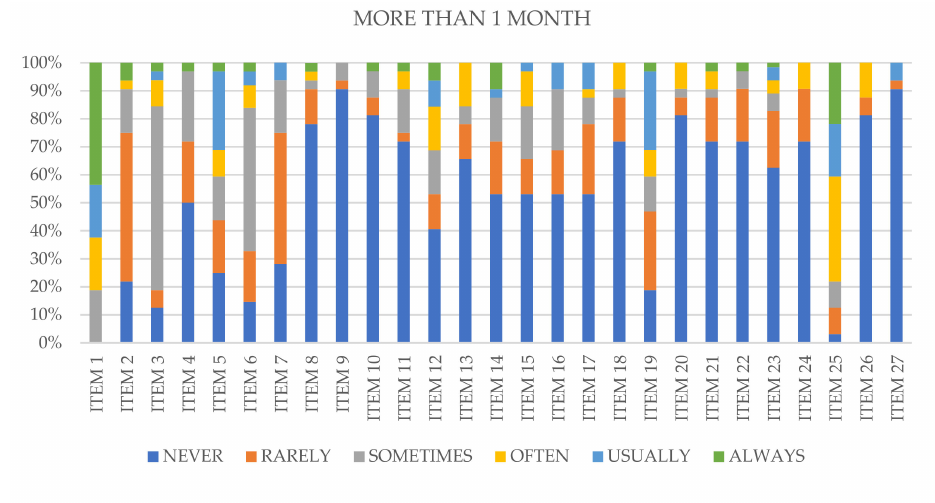
Figure 2. Answers of EAT-27 regarding the time involved for weight reduction (no reduction, less than one week, less than one month and more than one